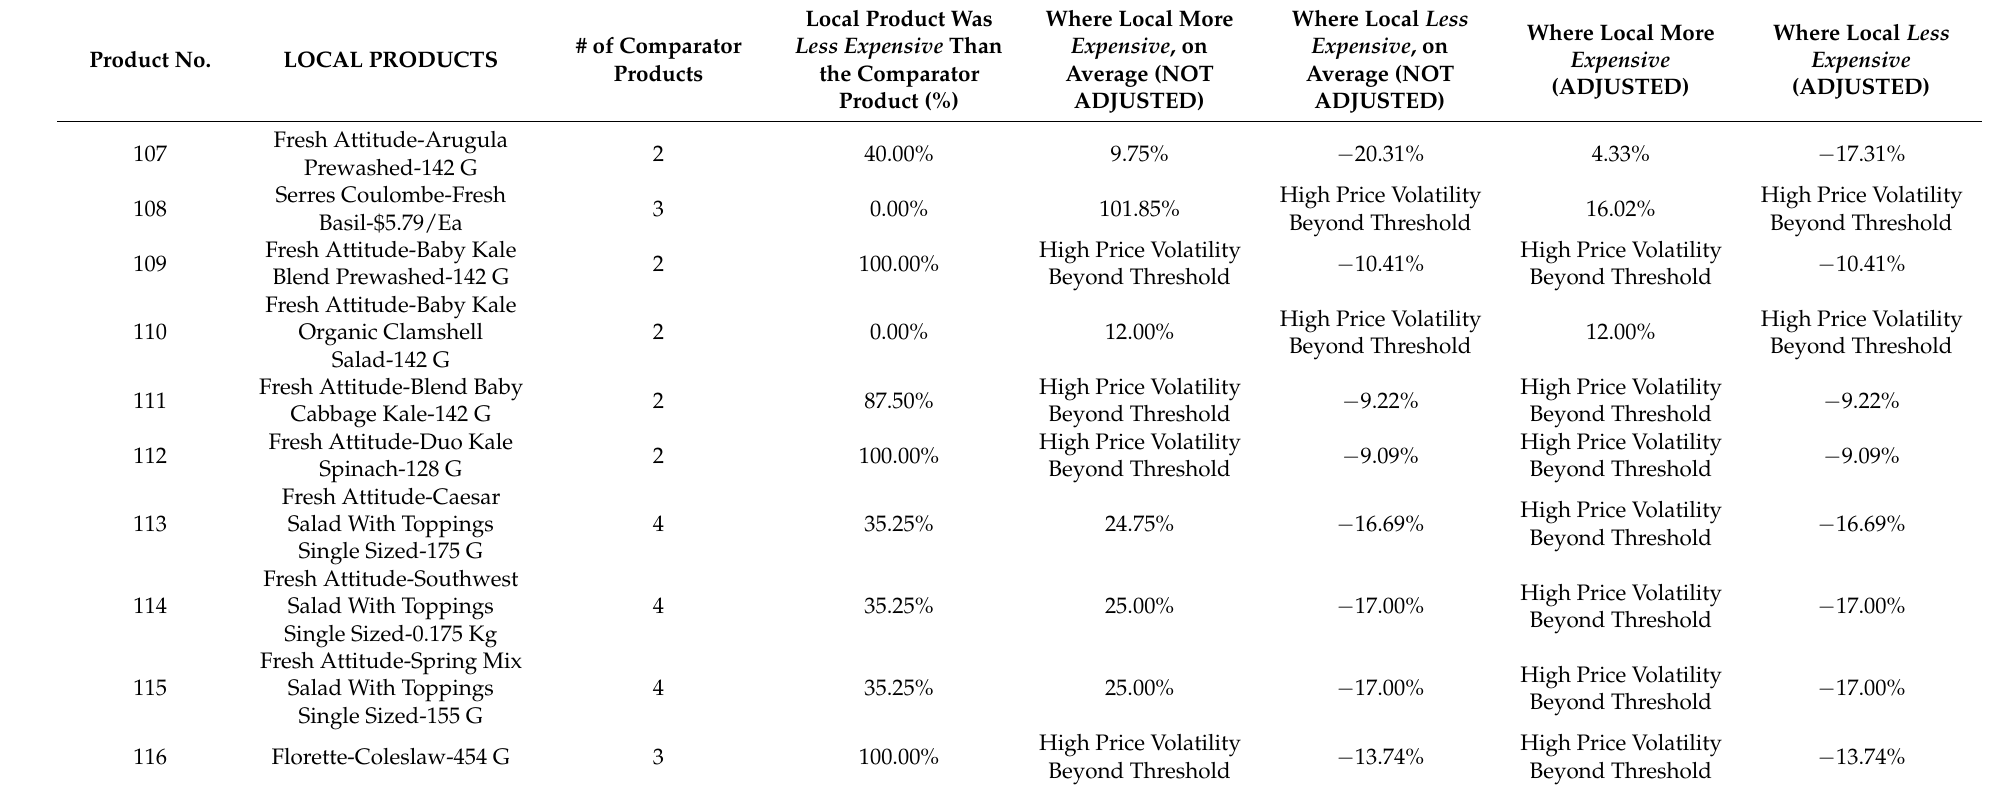
Table 8. Clamshell Salads, Fresh